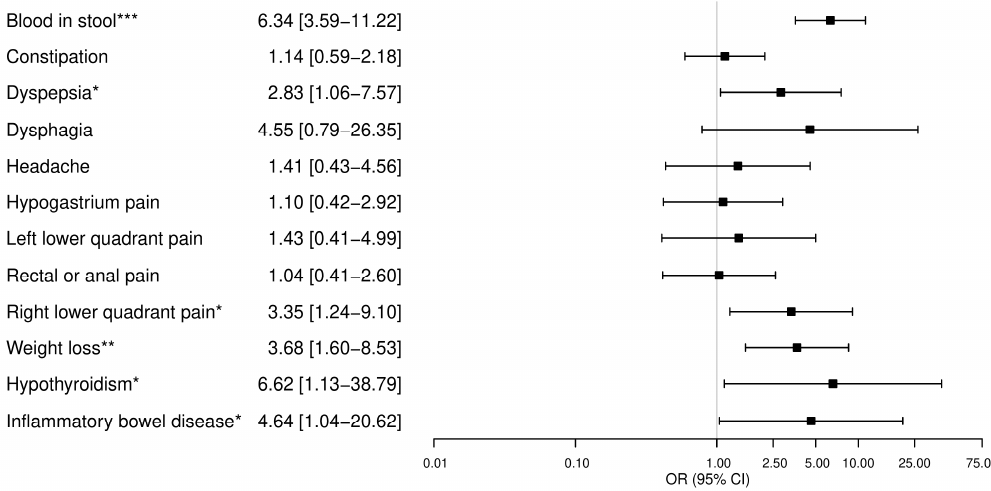
Figure 4. Multivariate logistic regression analysis. Dependent model: the initial post with at least one harmful answer (coded as one). The results are presented as odds ratio [95% confidence interval]. CI: Confidence Interval, OR: Odds Ratio, * p -value < 0.05, ** p -value < 0.01, *** p -value <